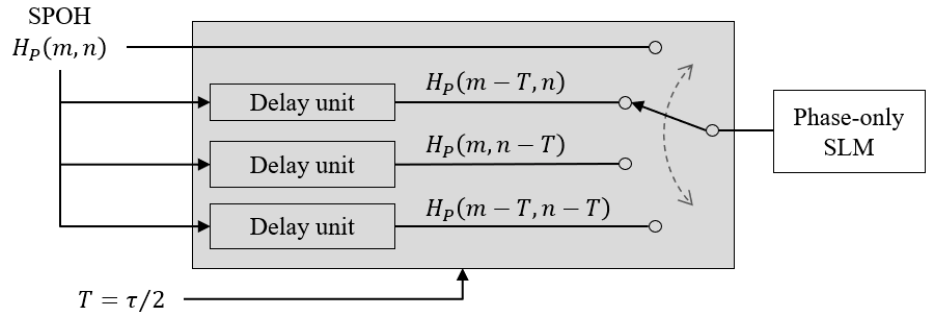
Figure 6. Two-dimensional time-division comb filtering (TDCF) for enhancing the reconstructed image of a SPOH.